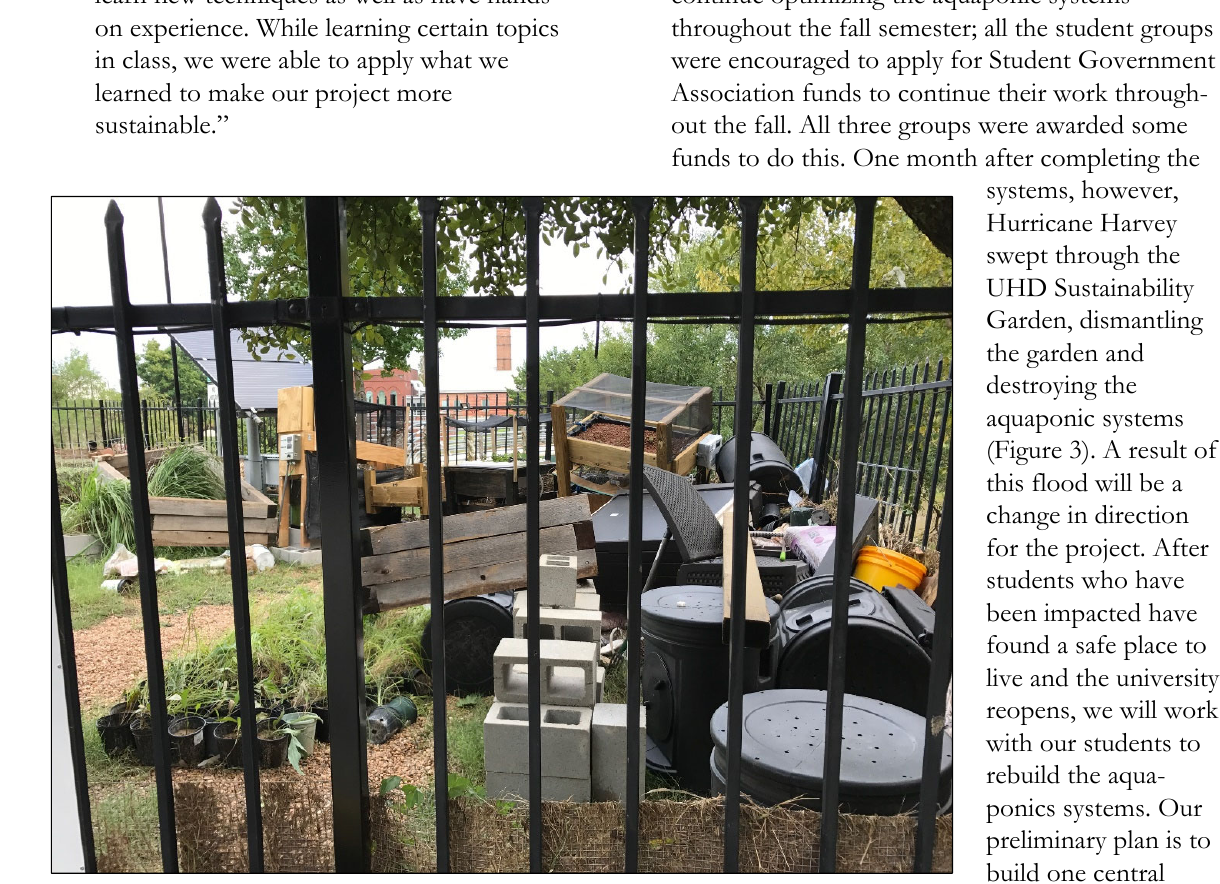
Figure 3. Photo of the UHD Sustainability Garden after it Was Ravaged by Hurricane Harvey The storm destroyed the aquaponic systems and damaged other features of the